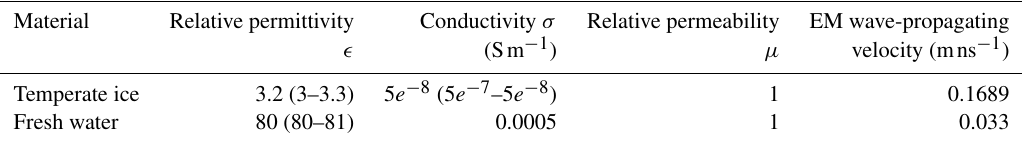
Table 4. Material properties for the forward modelling, taken from Plewes and Hubbard (2001), Reynolds (2011), and Langhammer et al. (2017). The values within the brackets represent the range of